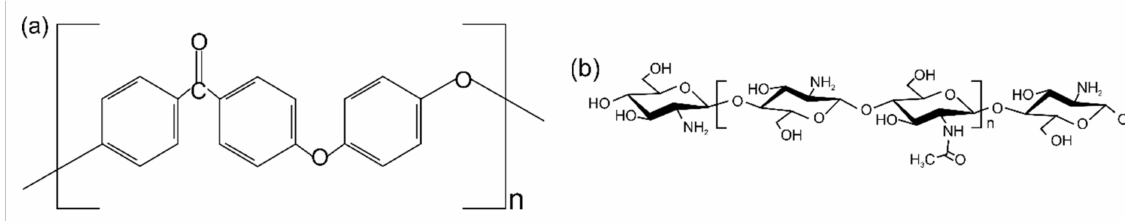
Figure 1. Chemical structures of PEEK ( a ) based on [42] and chitosan ( b ) based on [43]. The EPD process was executed in a two-electrode system, using an EX752M Multi- mode PSU power supply (AIM TTI, Huntingdon, UK) used as a direct current (DC) source. Zirconium alloy was the working electrode, and the counter electrode was an austenitic stainless steel plate. The constant current voltage range from 10 V to 150 V (with a change of 20 V) and a stable deposition time of 30 s were employed. A Tektronix DMM 4040 multi- meter (TEKTRONIX, Bracknell, UK) was utilized to measure the current density during the process. The deposition yield and rate of particles were studied during deposition at a constant voltage of 90 V and different times of 10 s, 20 s and 30 s. The samples were weighed using an Ohaus Europe GmbH analytical scale (Nänikon,